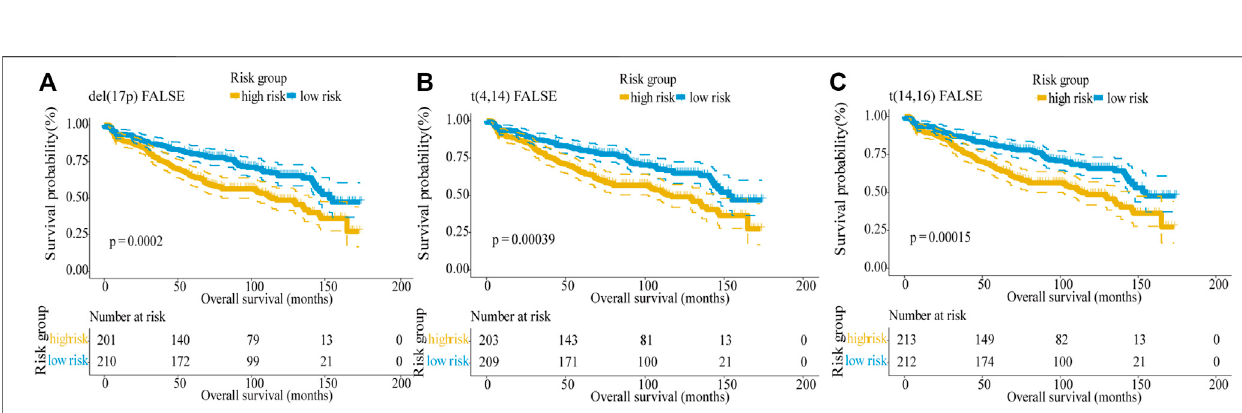
Figure 6B ). But for patients with t (4,14), the difference between the two groups was not signi fi cant (log-rank p (cid:1) 0.1; Supplementary Figure S2D ). Since there was only 1 MM patient with t (14,16), t (14,16) also cannot be used as a predictor of prognosis (log-rank p (cid:1) 0.48, Supplementary Figure S2E ). For 425 MM patients without t